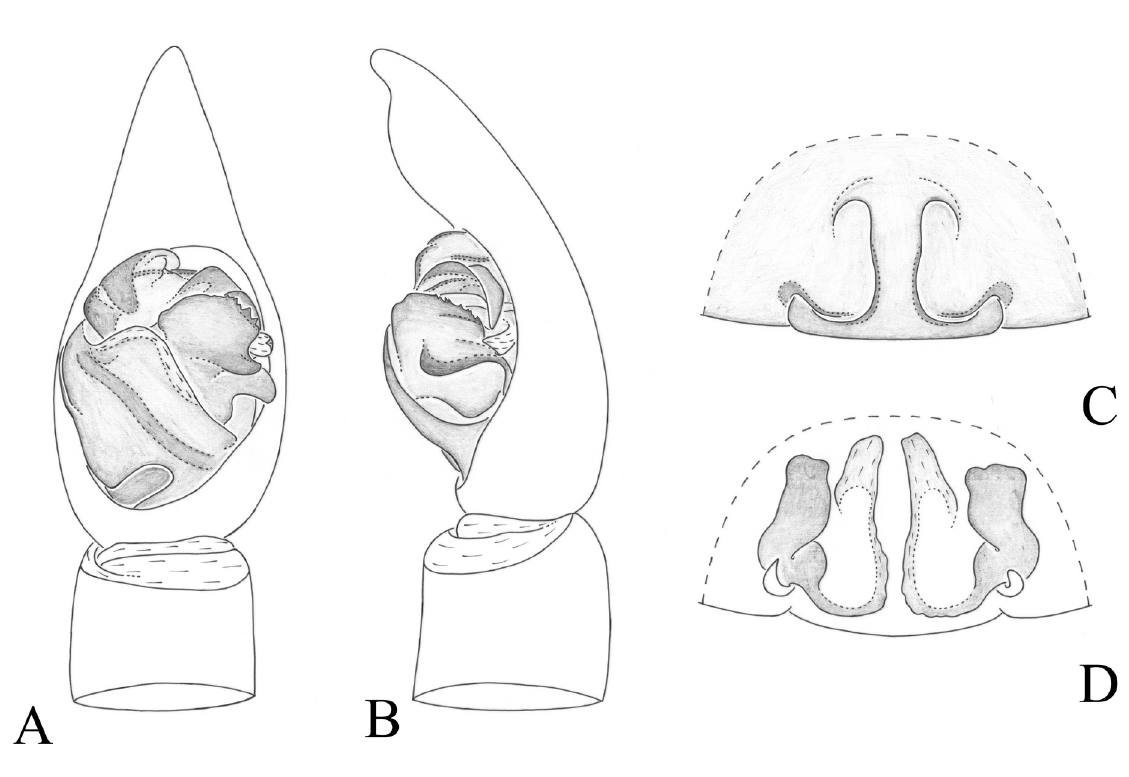
Fig. 4. Serratacosa multidontata (Qu, Peng & Yin, 2010) comb. nov. A–B . Paratype, ♂ (HNU). C–D . Paratype, ♀ (HNU). A . Left pedipalp, ventral view. B . Left pedipalp, retrolateral view. C . Epigyne, ventral view. D . Vulva, dorsal